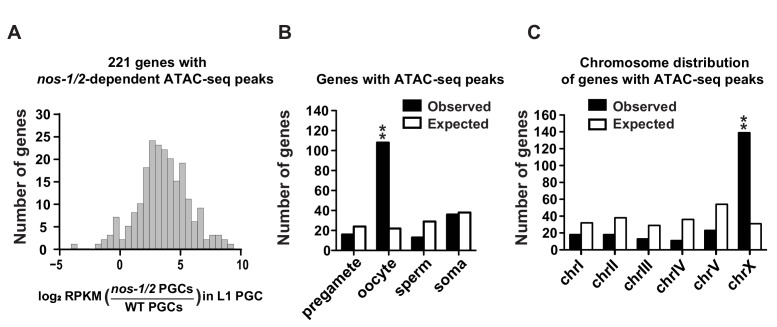
nos-1nos-2 L1 PGCs activate the transcription of oocyte and X-linked genes.(A) Histogram showing the distribution of log2 fold change in gene expression between nos-1(gv5)nos-2(RNAi) (designated as nos-1/2) and wild-type L1 PGCs for 221 genes that acquired new ATAC-seq peaks in nos-1(gv5)nos-2(RNAi) PGCs (Supplementary file 2). Consistent with ATAC-seq peaks denoting open chromatin, most genes are expressed at higher levels in nos-1(gv5)nos-2(RNAi) PGCs compared to wild-type. (B) Bar graph showing expected and observed number of genes with nos-1nos-2 -dependent ATAC-seq peaks in the different expression categories. Asterisks indicate significantly more genes than expected (hypergeometric test, p-value<0.001 [**]). (C) Bar graph showing the chromosomal distribution of genes with nos-1nos-2 -dependent ATAC-seq peaks. Asterisks indicate significantly more genes than expected (hypergeometric test, p-value<0.001 [**]).